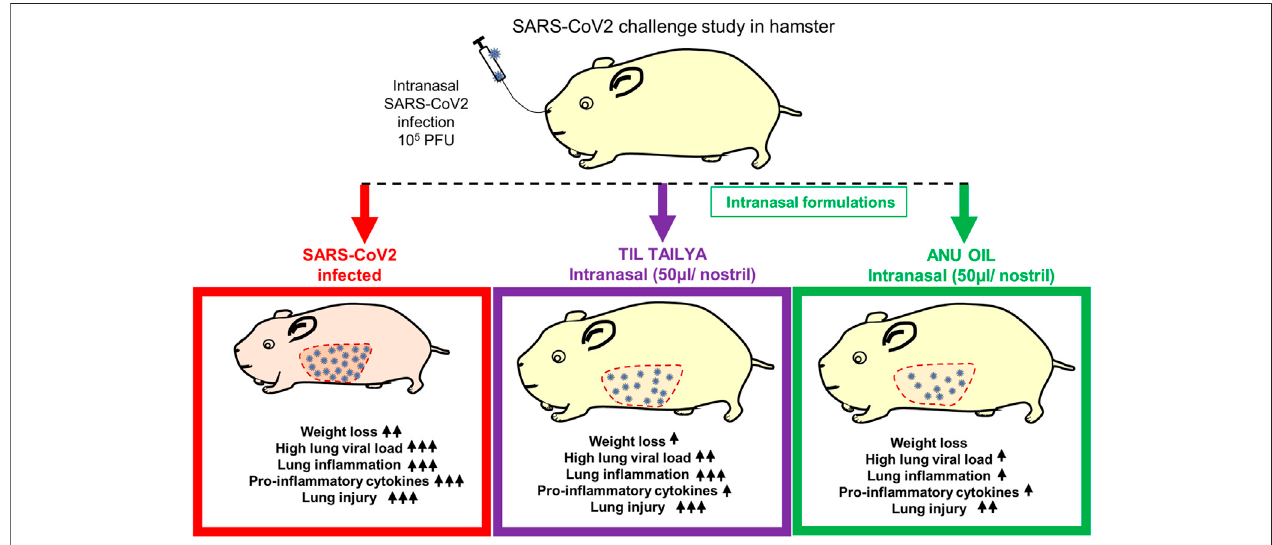
FIGURE 5 | Summary representing the important fi ndings of the study. Diagrammatic representation of the effect of pretreatment of intranasal til tailya and Anu oil against SARS-CoV2 – associated pathologies in golden Syrian hamster. ns (cid:2) non-signi fi cant.